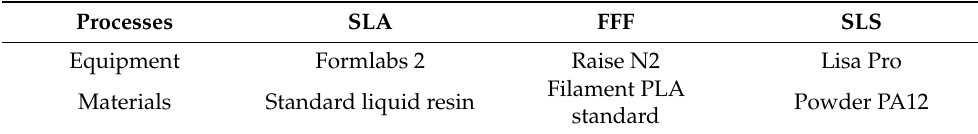
Table 2. Processes, equipment and materials selected.